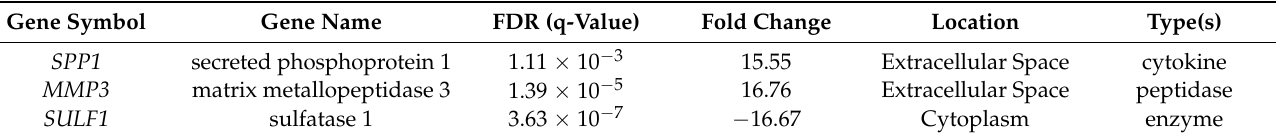
Table 1. The Expressions of the mostly altered genes implicated in migration and invasion.